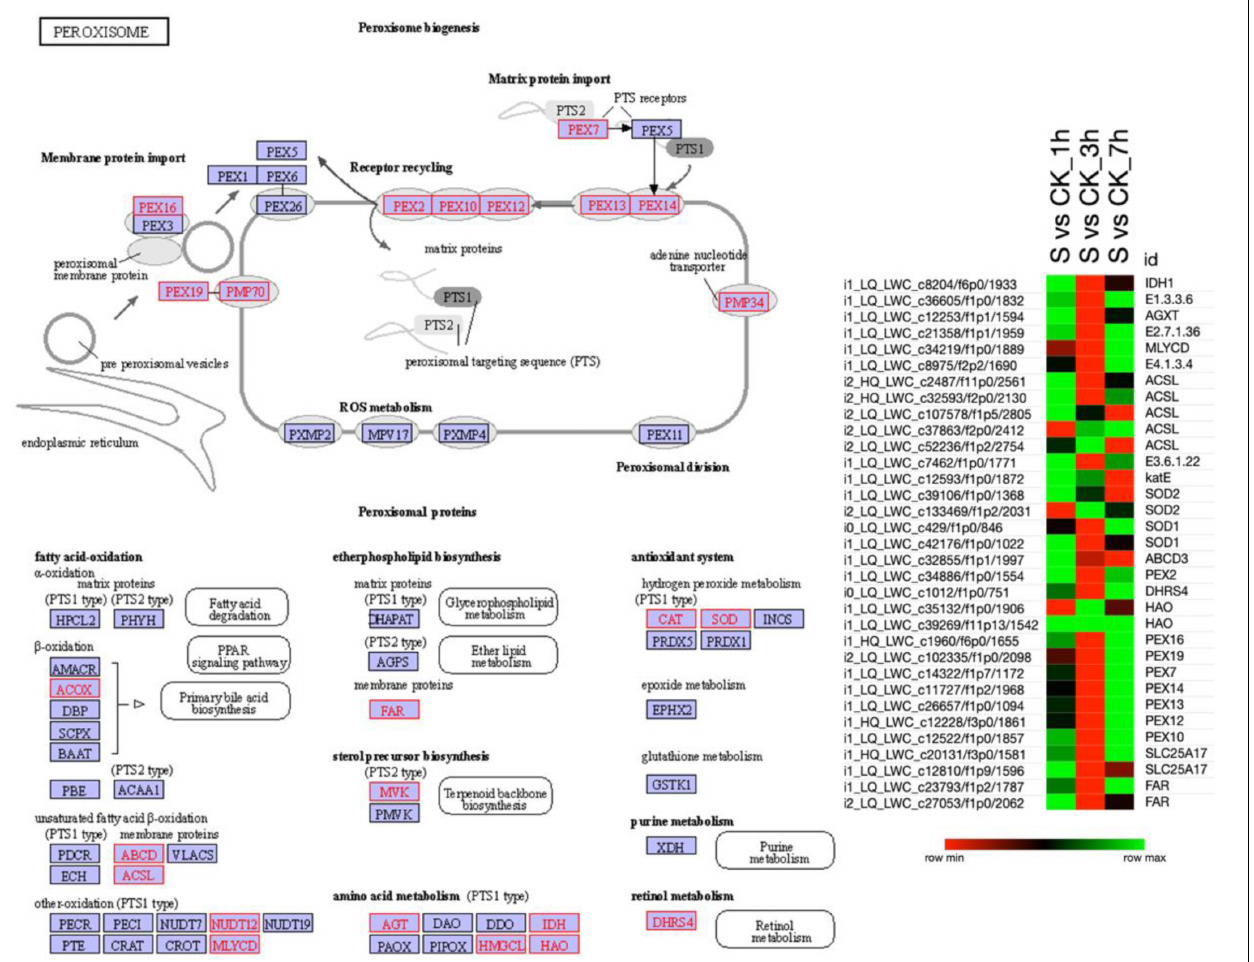
FIGURE 5 | The KEGG analysis shows enrichment of DETs involved in the “Peroxisomal pathway”. Red color boxes are exhibiting the involvement of DETs in the peroxisome pathway, whereas, the heatmap illustrates the expression pattern of DETs in pearl millet leaves under salt stress. Here, the green color in the heatmap shows the upregulation of DETs and the red color shows the downregulation when the DETs were compared among various combinations as mentioned on the top of each column. Moreover, “S” is indicating salt-treated groups, “CK” is indicating the control group, and “h” is used for hours, i.e., 1 hour (1 h), 3 hours (3 h), and 7 hours (7